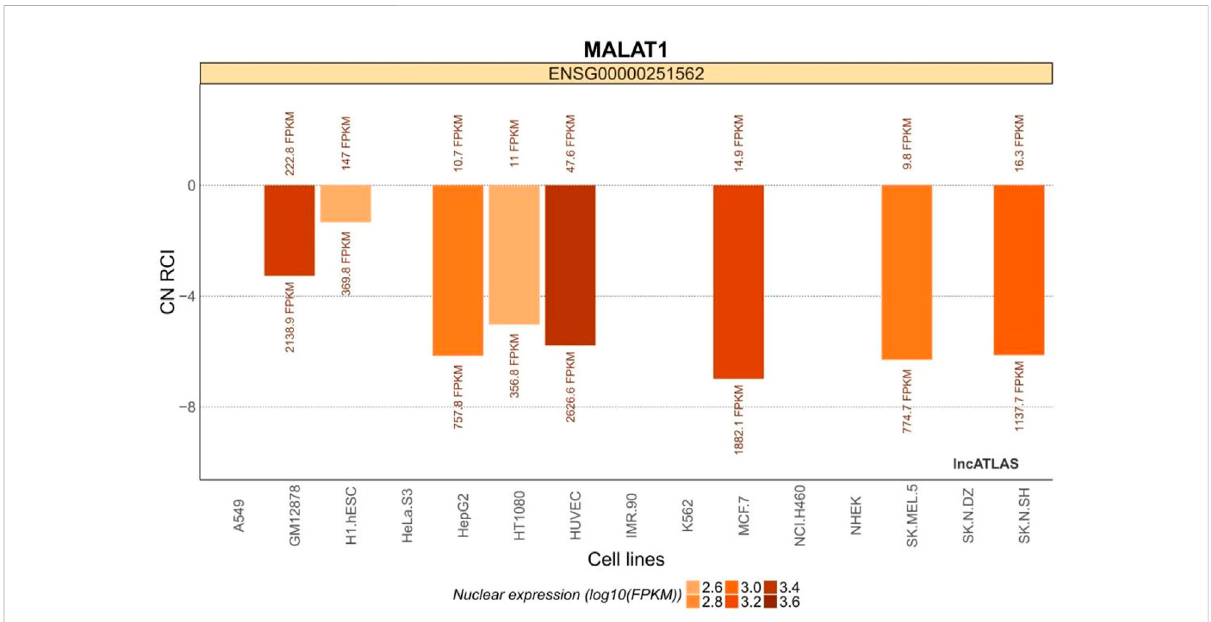
FIGURE 1 MALAT1 expression in common cell lines. The relative concentration index (RCI) was calculated using RNA-Seq data for each cellular fraction harvested by ensemble. The values above and below each cluster bar graph are the number of reads expressed by MALAT1 in the cytoplasm and nucleus of that cell line, respectively. The CN RCI values for MALAT1 were expressed in both the cytoplasm and the nuclei but were relatively more abundant in the latter. Positive values indicate localization to the cytoplasm and negative values indicate localization to the nucleus. Absolute values increase with localization intensity. Abbreviations: C, cytoplasmic; N = nuclear.